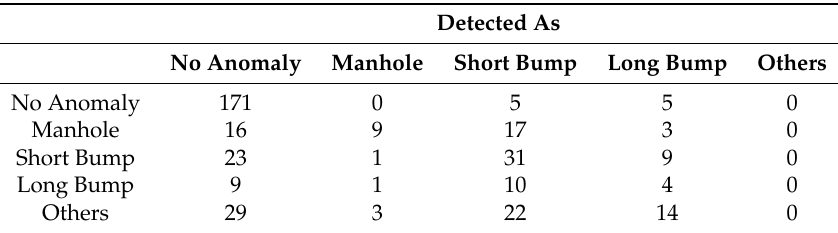
Table 4. Confusion matrix for real world